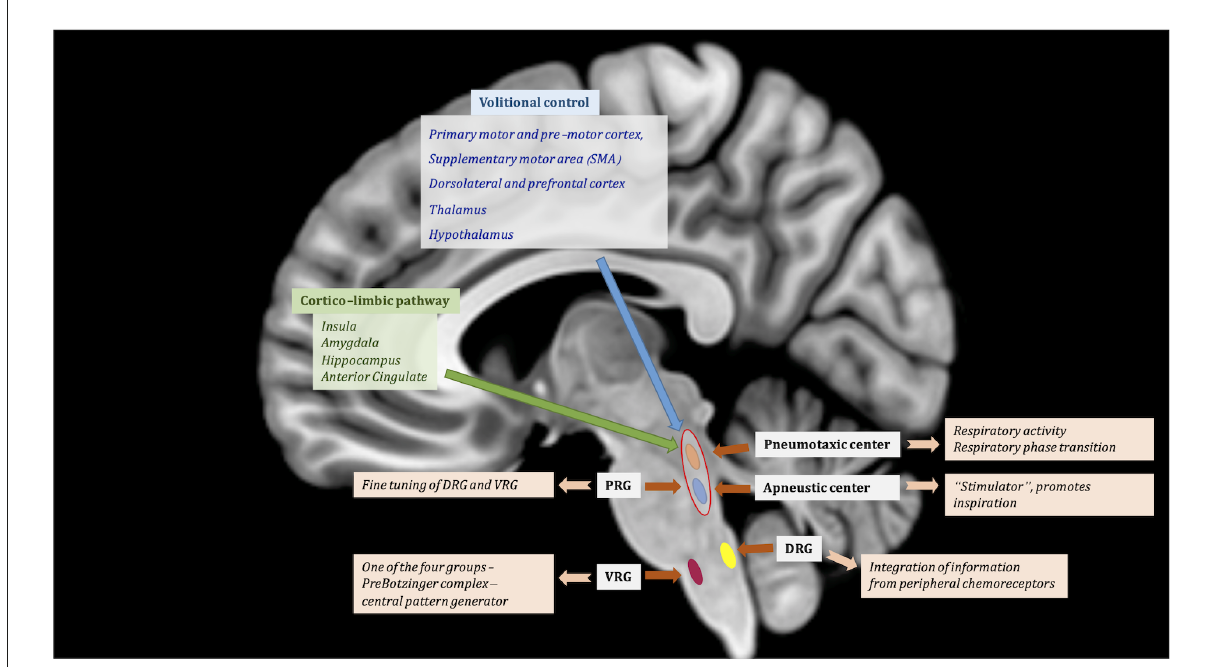
FIGURE1 Central regulation of respiratory function. Suprapontine modulation of breathing through volitional control (blue) and corticolimbic pathway (green). Automatic regulation is assured by the brainstem centers contributing to the respiratory drive: (1) Pontine respiratory group (PRG) is represented by the pneumotaxic center and the apneustic center; and (2) Medulla—respiratory centers comprised of the dorsal respiratory group (DRG) and ventral respiratory group (VRG), the latter is part of the ventral respiratory column. The VRG is composed of four groups of neurons: (1) the Bötzinger complex; (2) caudal VRG; (3) the Prebötzinger complex; and (4) the rostral VRG. MNI T1 in sagittal projection was used for illustration.